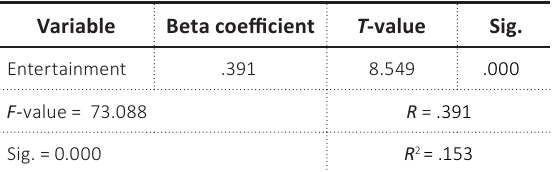
Table 12. Simple linear regression for testing the second hypothesis